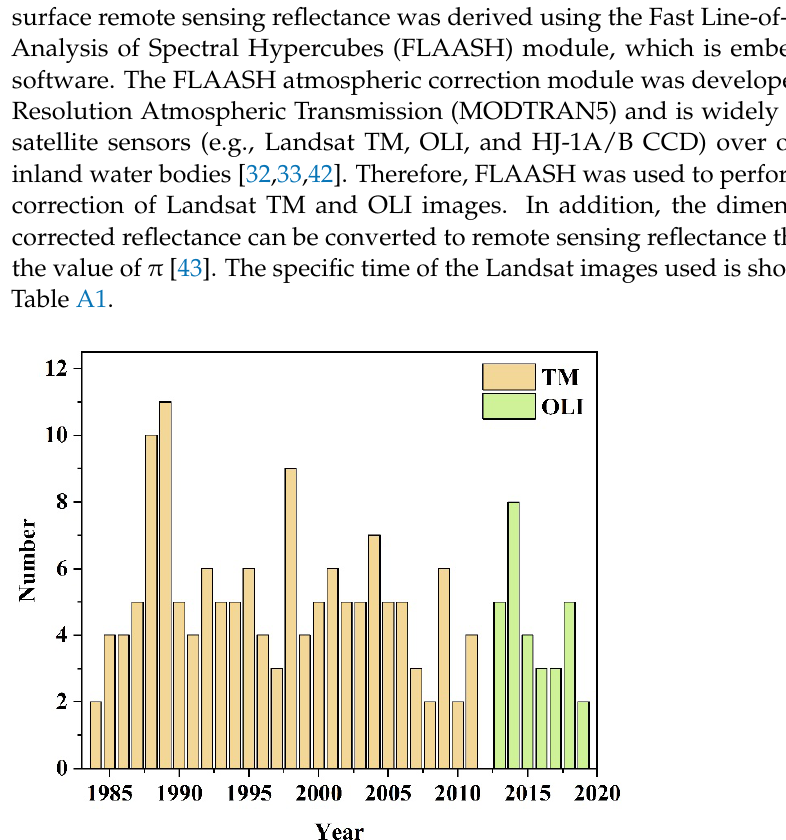
Figure 3. Valid Landsat images from 1984 to 2019. Gray and blue correspond to the year when TM and OLI have data, respectively.